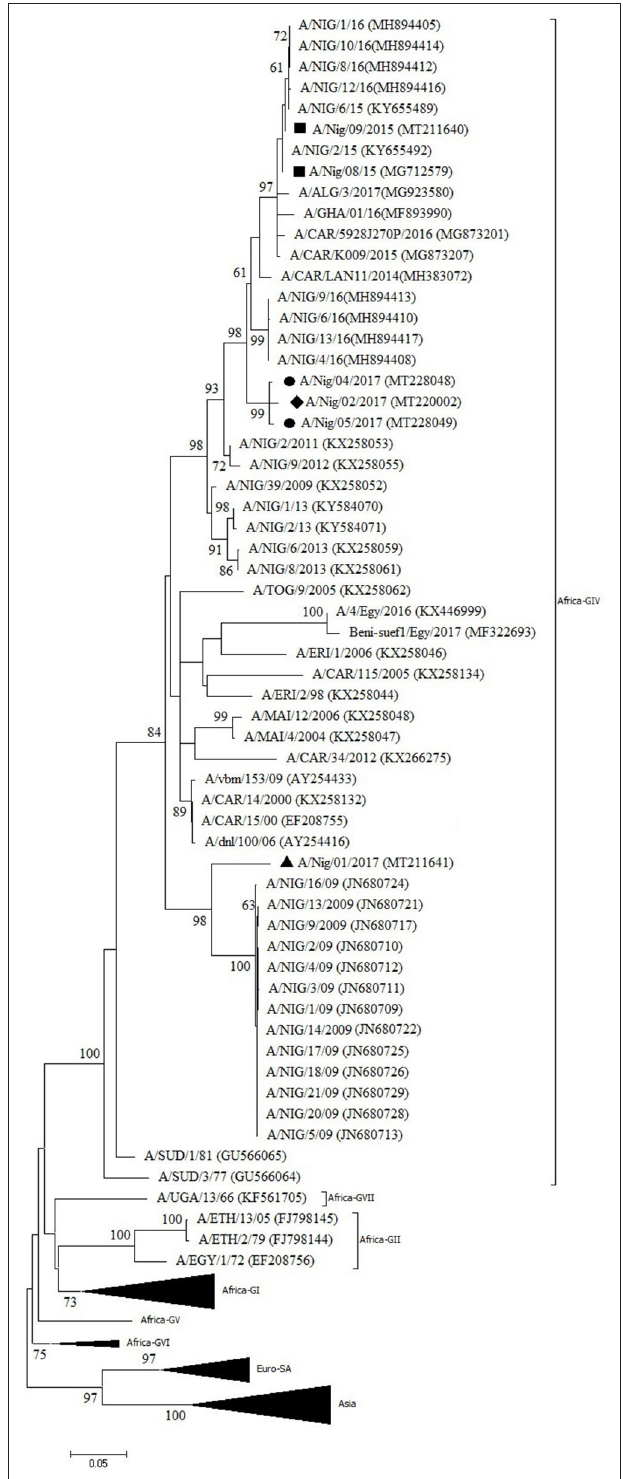
FIGURE 3 | VP1 phylogenetic tree for foot-and-mouth disease virus (FMDV) serotype A inferred using the maximum likelihood method based on the Tamura-Nei model. Branch lengths indicate the number of substitutions per site. Bootstrap values ≥ 60% are indicated at the nodes. Novel Nigerian FMDV from this study from Kaduna is indicated with • , from Bauchi with (cid:4) , from Oyo with N and from Benue with (cid:7) .